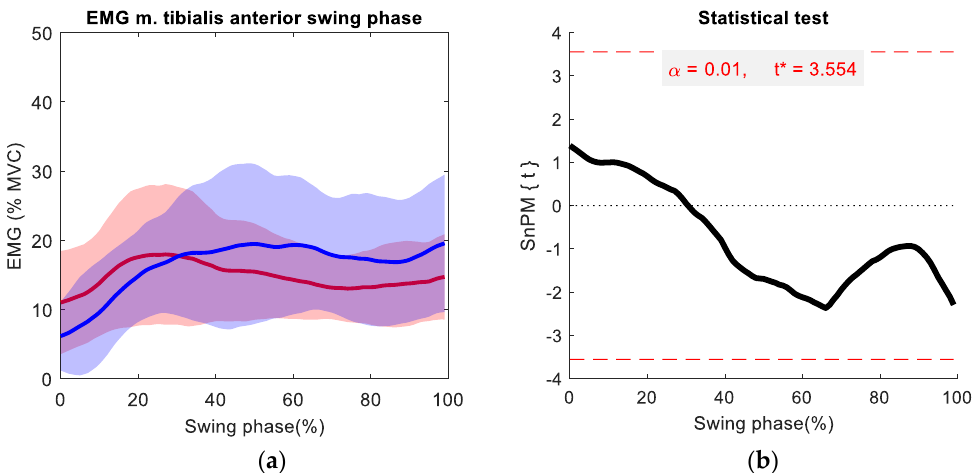
Figure 10. ( a ) Mean EMG curve of m. tibialis anterior with (red) and without (blue) wearing exosuit, and ( b ) statistical 1D SnPM test; * critical t-value.